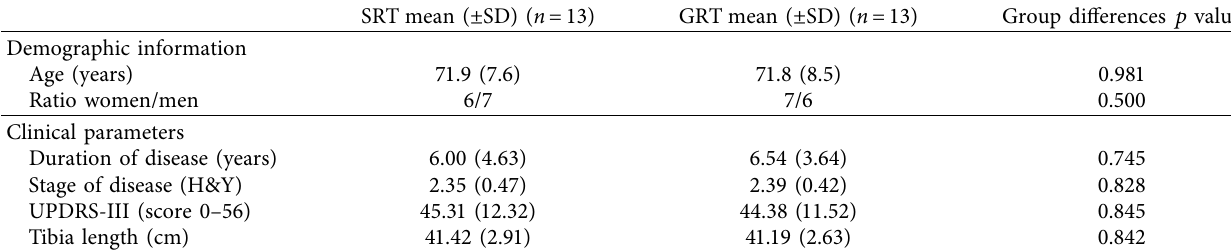
Table 1: Demographic and clinical information of the participants.